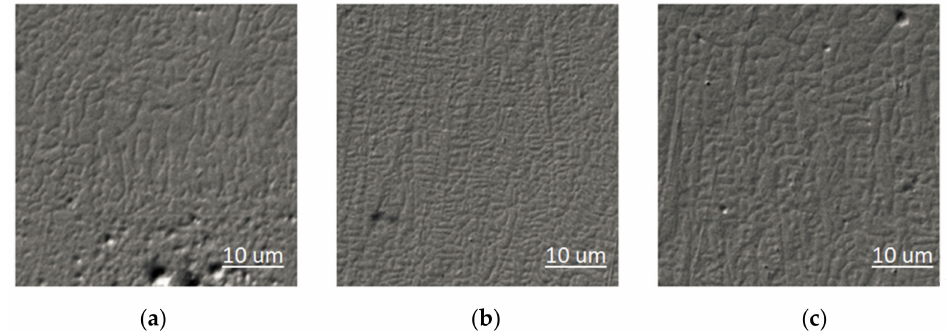
Figure 3. Cross-section structure of Fe-based alloy laser cladding layer on the 27SiMn surface: ( a ) bottom of the cladding layer; ( b ) middle of the cladding layer; ( c ) upper part of the cladding